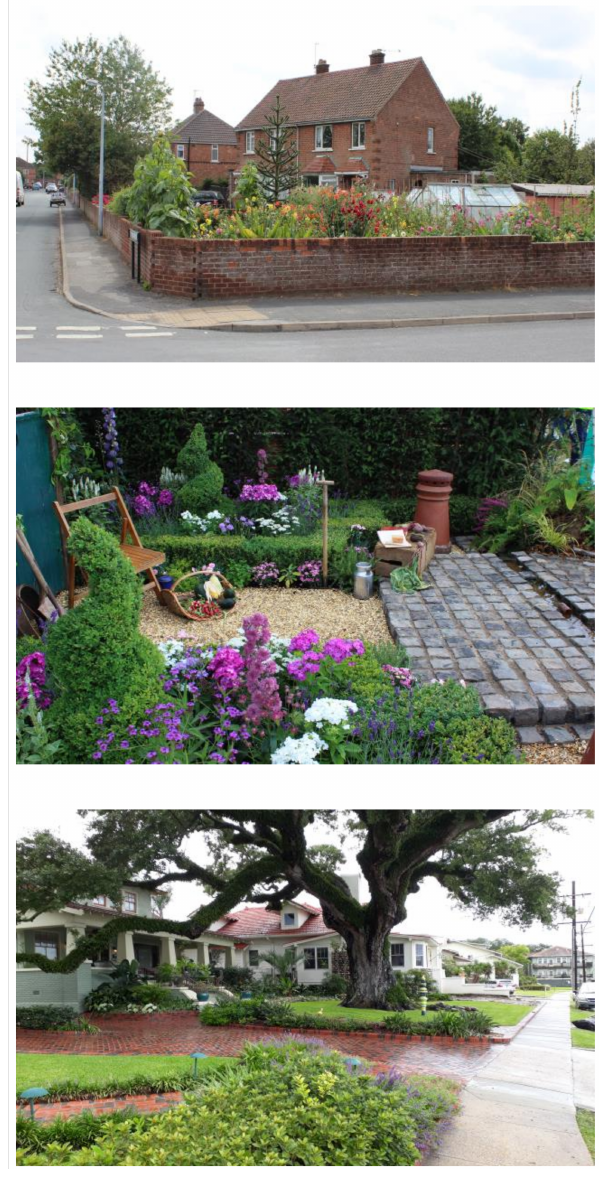
Figure 1. Contrasting styles / vegetational components of front gardens